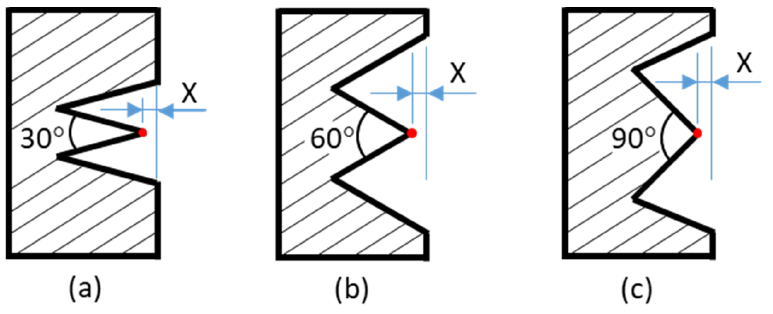
Figure 1. Corner error measurement ( a ) 30°, ( b ) 60°, ( c ) 90°.